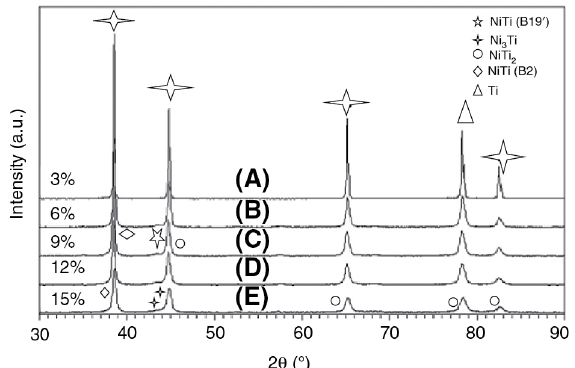
Figure 4: X-ray diffraction at (A) 3% binder; (B) 6% binder; (C) 9% binder; (D) 12% binder; (E) 15%